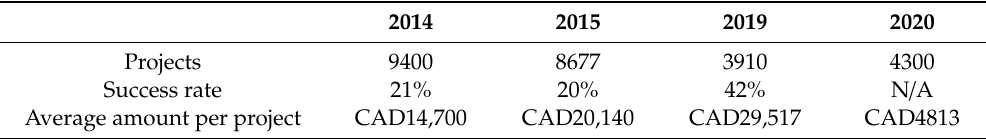
Table A5. Crowdfunding in